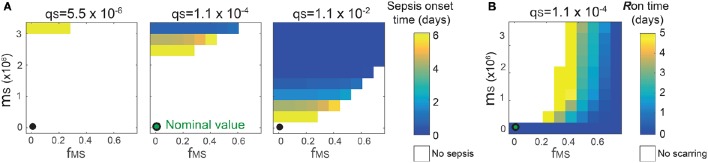
Combinatorial effects of the three most sensitive parameters (θS, μS and ϕMS) on the sepsis onset time (A) and the Ron time (B). The black circles correspond to the nominal values for (μS, ϕMS) and the nominal value for θS is 1.1 × 10−4. Changes in θS do not affect the Ron time.